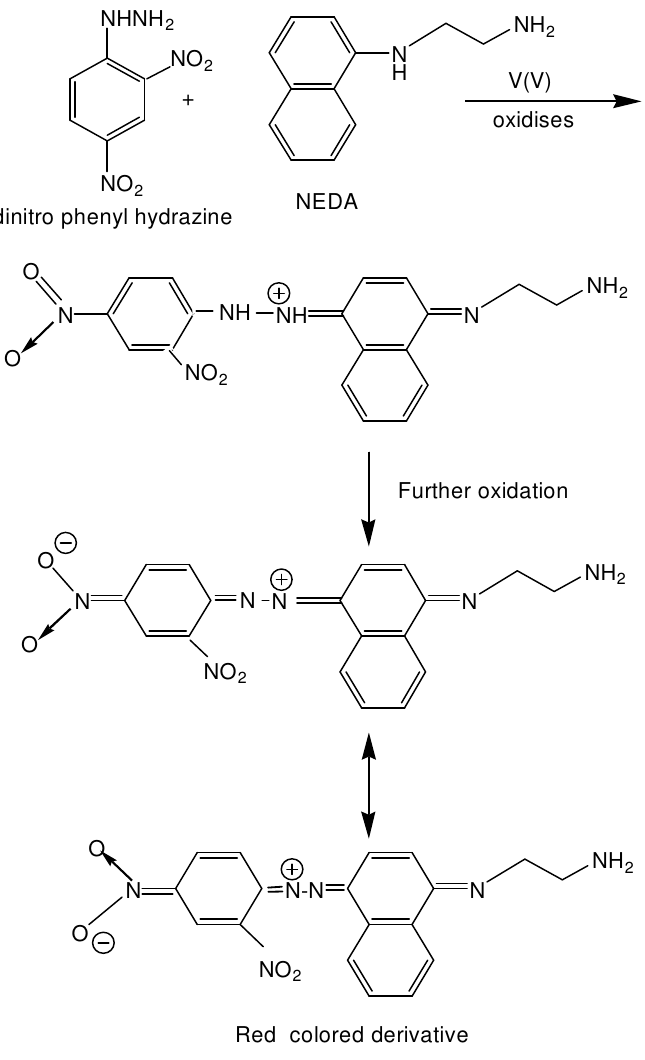
Scheme 1: Oxidative coupling reaction of 2,4-dinitrophenylhydrazine wit h NEDA